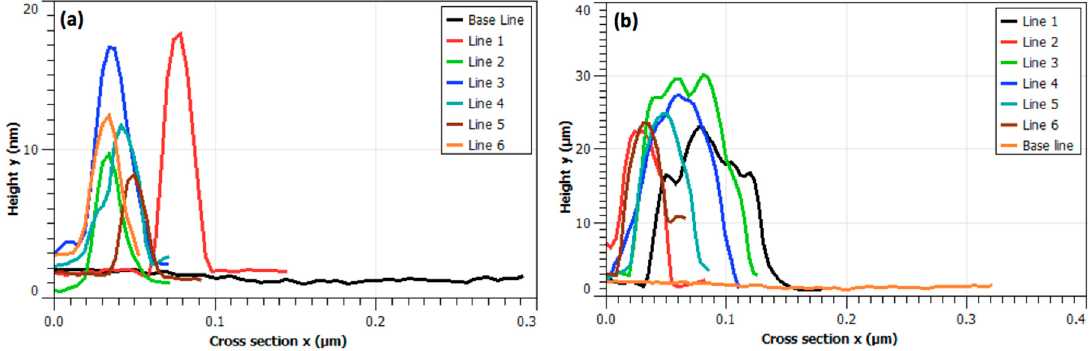
Figure 3. AFM images of CsWO 3 NPs-doped LAFs with increasing magnification indicated by scale bars of 500 nm, 250 nm and 125 nm from left to right, are illustrated. Blue and white arrows mark the corresponding location of NP clusters and fibrils, and the dimension analysis of LAFs and nanocomposites are pointed out by enumerated blue and white lines, respectively.